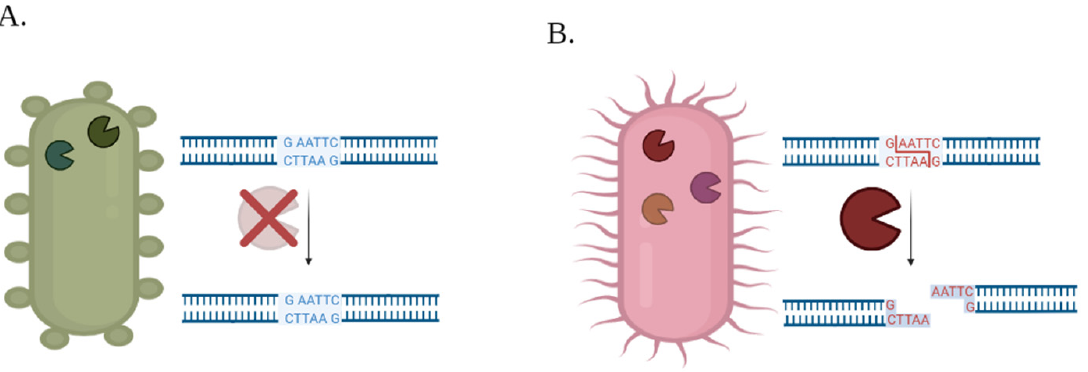
Figure 6. Effect of different restriction enzyme arrays in different species: ( A ) the restriction sites don’t fit to the restriction enzyme in the environment; thus, the nucleotides are not digested. In contrast, and ( B ) exhibits a pair of matching restriction sites and enzymes, so digestion occurs.